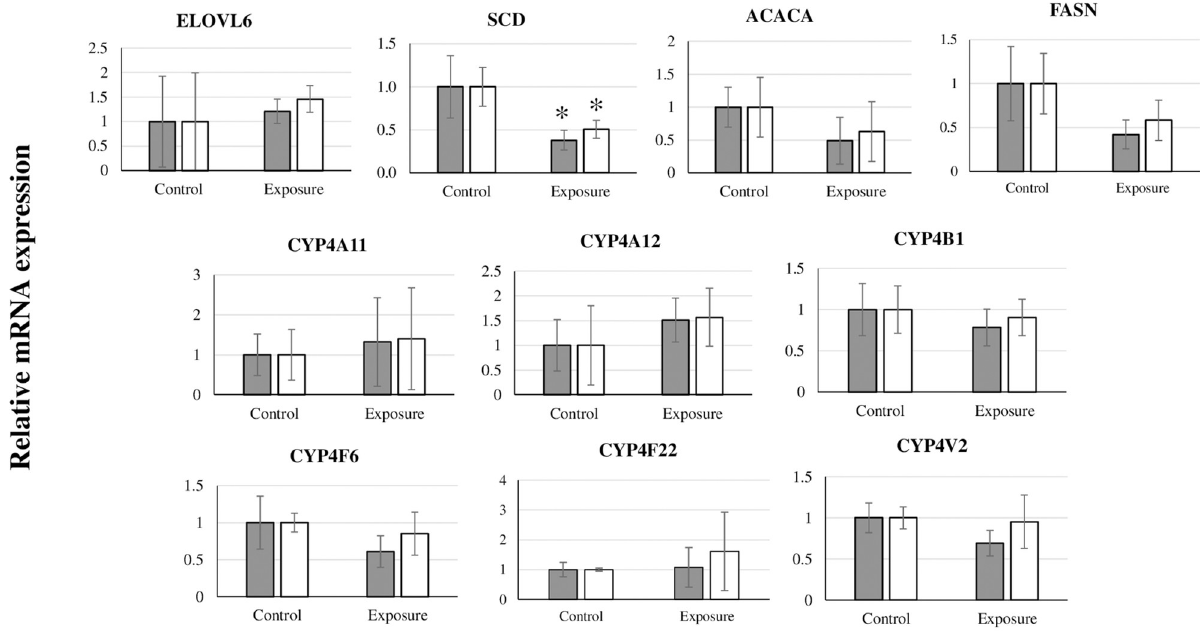
Fig 6. Relative gene expressions (mean ± SD) in the liver of the control and BDE-209 treatment groups (reference genes: GAPDH [gray bar] and ACTB [white bar]. � : Significant differences between two groups, P < 0.05).